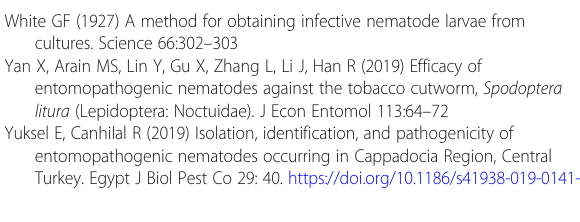
White GF (1927) A method for obtaining infective nematode larvae from cultures. Science 66:302 –